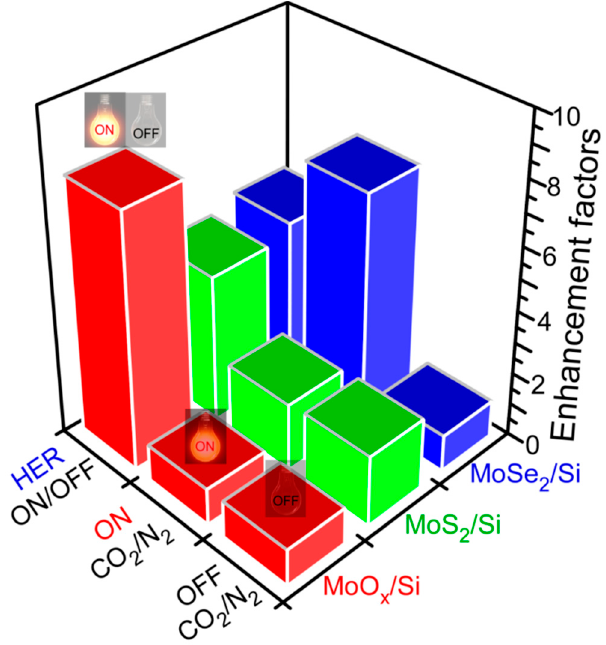
Figure 6. Enhancement factors for HER CD light ON / HER CD light OFF , CD CO2 bubbling / CD N2 bubbling under light ON condition and CD CO2 bubbling / CD N2 bubbling under the light OFF condition for ( a ) MoO x /Si, ( b ) MoS 2 /Si and ( c ) MoSe 2 /Si samples.